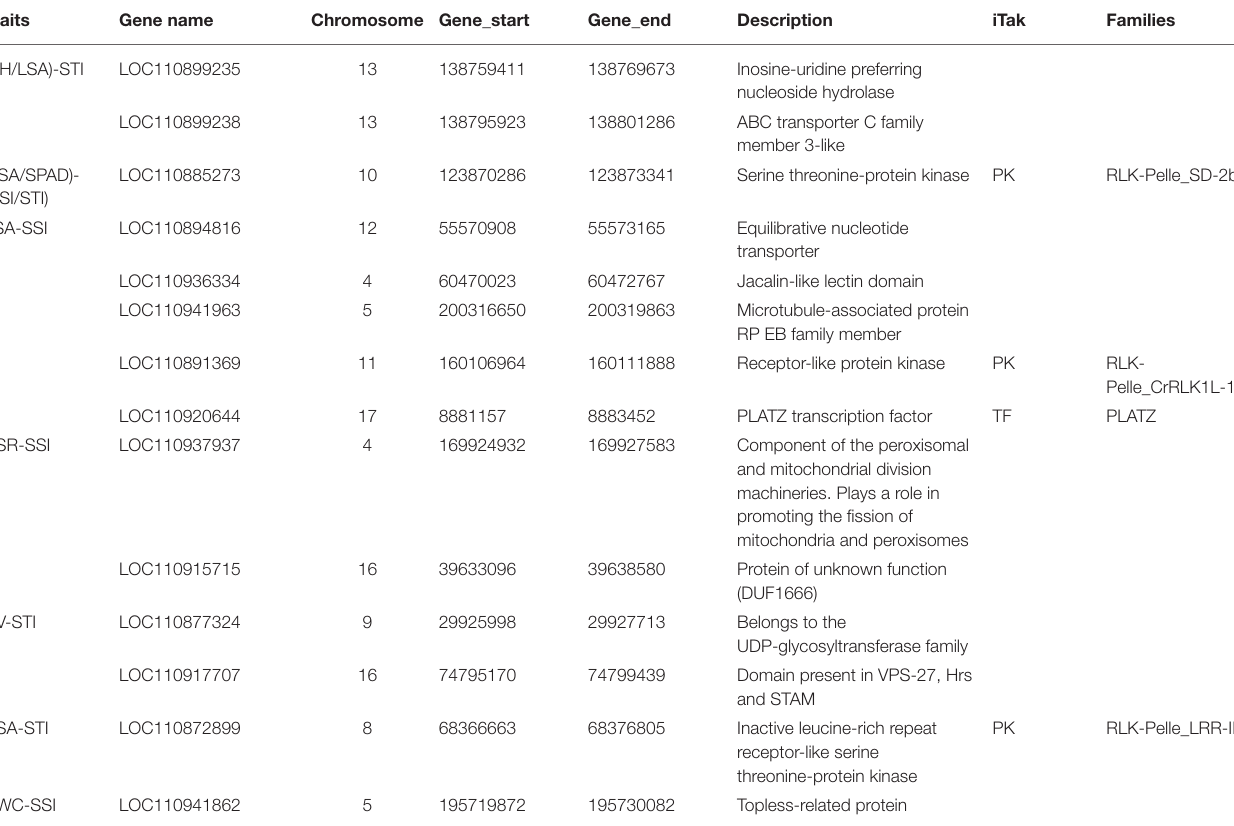
TABLE 2 | Detail information of 14 genes obtained by combine-analysis of GWAS and RNA-seq.